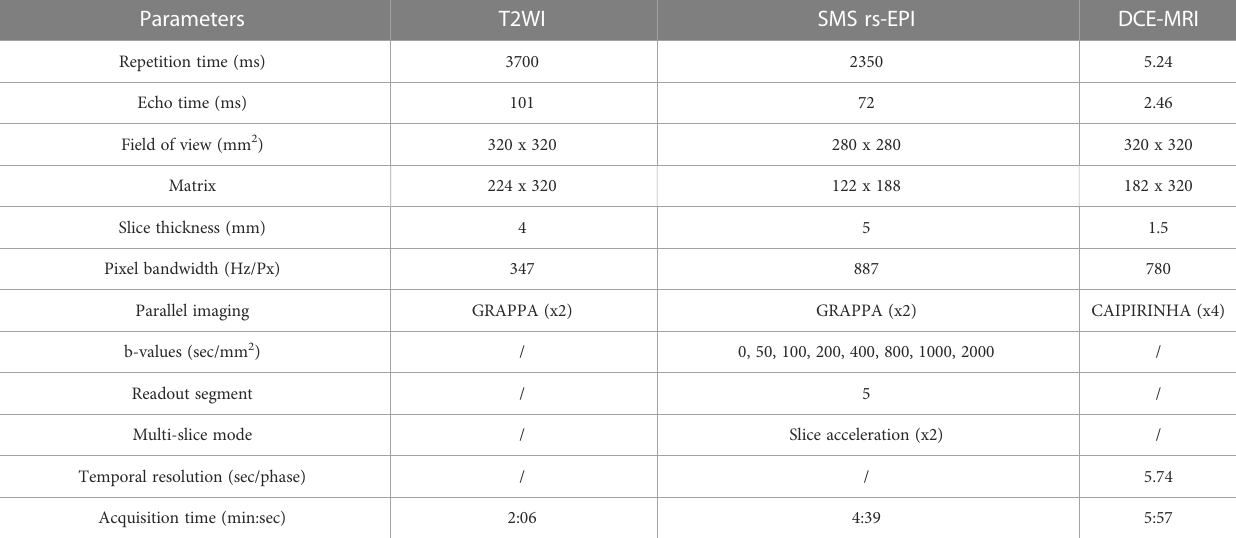
TABLE 2 Sequence parameters for T2-weighted imaging, SMS rs-EPI, and